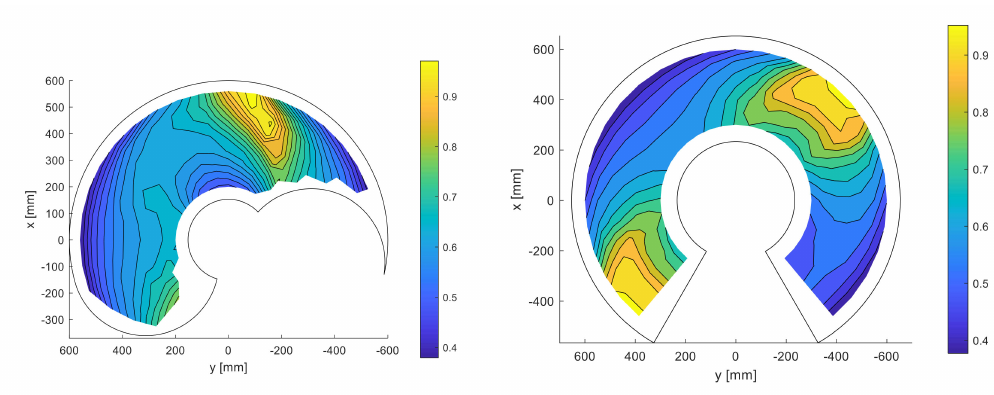
Figure 9. Normalized maximum speeds of the SCARA ( left ) and the articulated ( right )